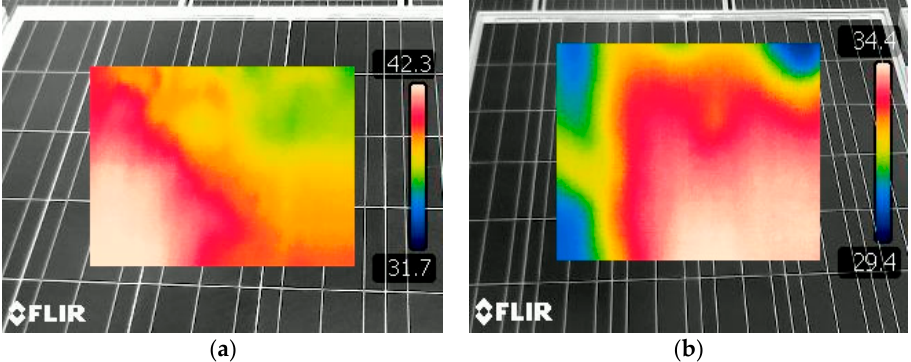
Figure 9. PV panel ( a ) and PVT collector ( b ) temperature by thermal imaging camera.